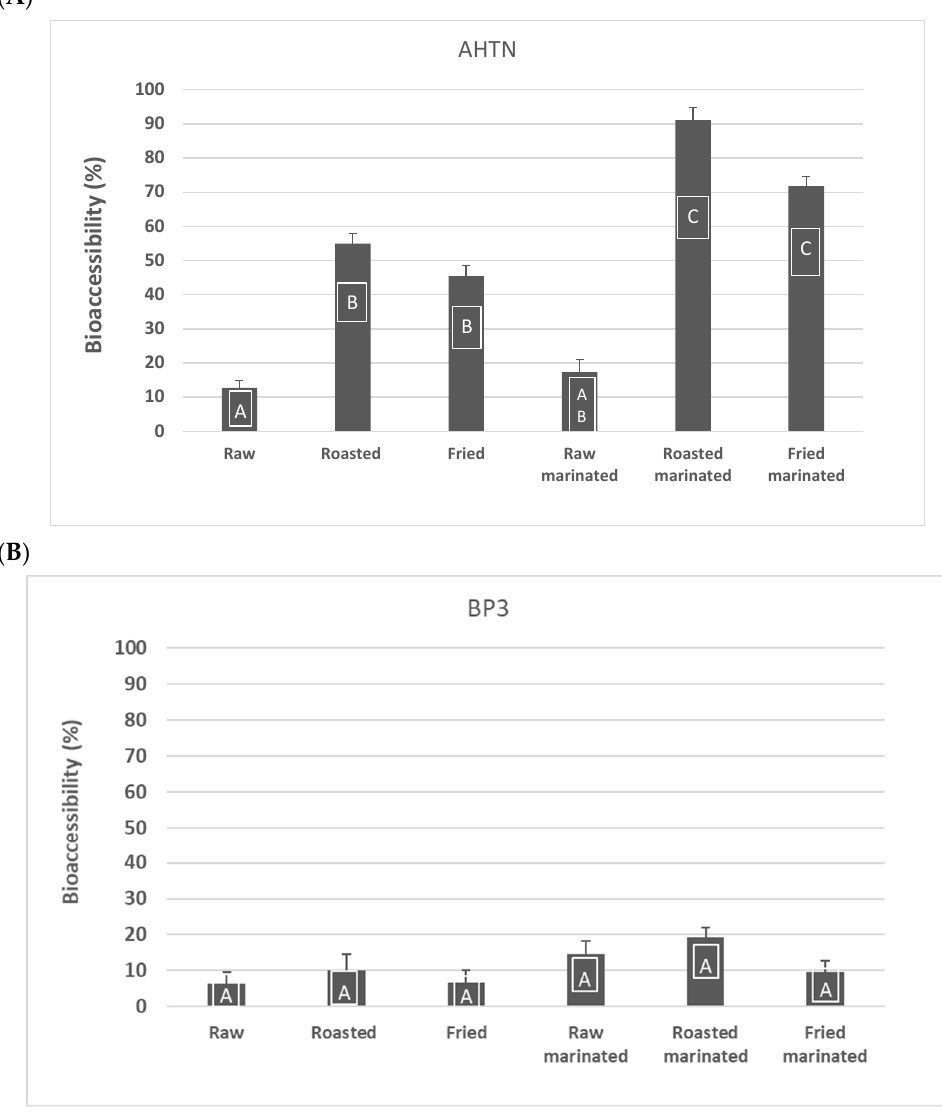
Figure 2. Bioaccessibility in the upper gastrointestinal tract of AHTN ( A ) and BP3 ( B ) from European seabass ( Dicentrarchus labrax ). Different letters in each column show statistically significant differences ( p < 0.05) from the given mean. Means were compared by Tukey HSD test or Dunnet’s T3 test, respectively, depending on whether or not homogeneity of variances was confirmed by Leven’s